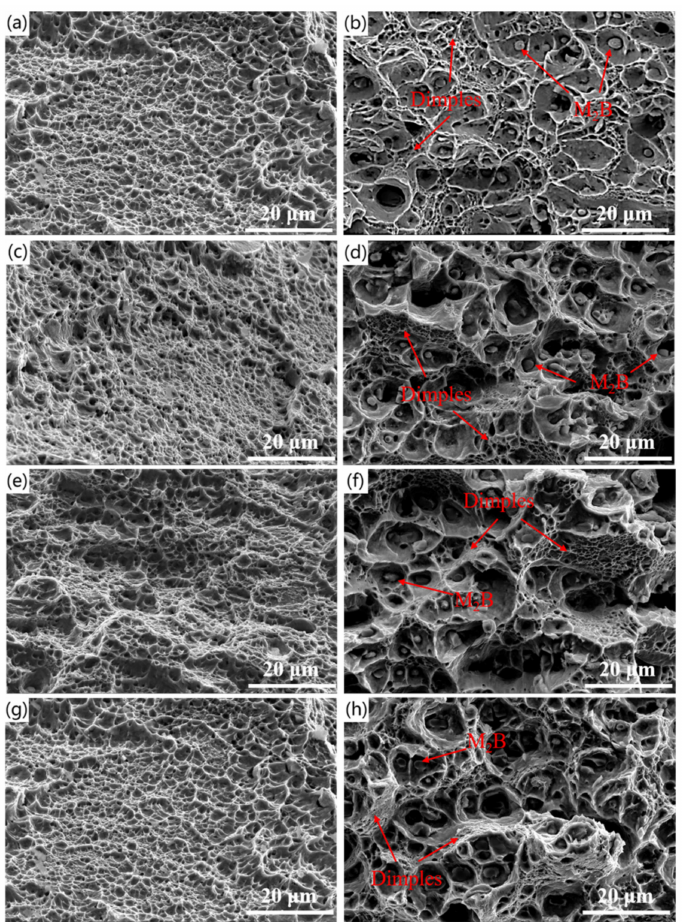
Figure 9. Fracture morphologies of the samples. ( a ) 0B-600; ( b ) 30B-600; ( c ) 0B-700; ( d ) 30B-700; ( e ) 0B-800; ( f ) 30B-800; ( g ) 0B-900; ( h )